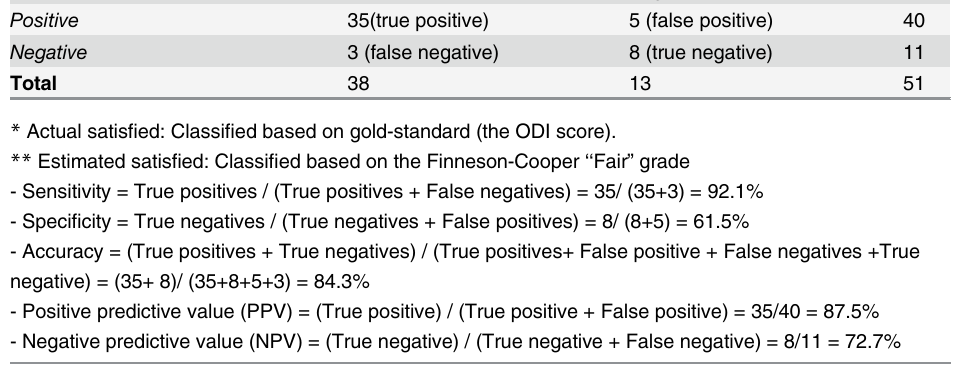
Table 3. Two-by-two matrices of the relationship between the estimated dissatisfied and the actual dissatisfied (sensitivity analysis). Actual satis fi ed * Estimated satis fi ed